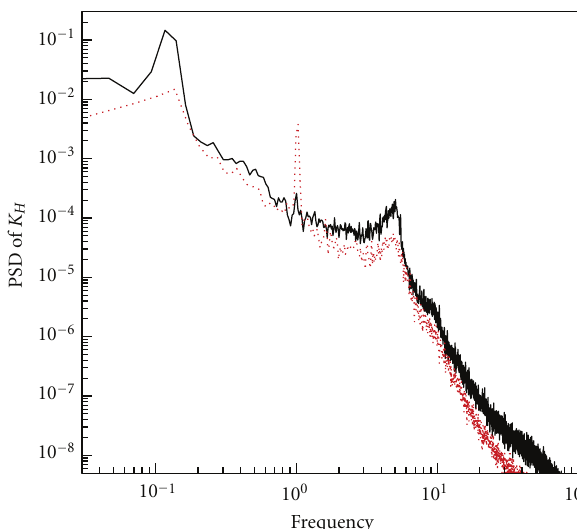
Figure 9: Power spectral density of K H at J = − 1 . 0 (solid line w/ hull; dashed line w/o hull).